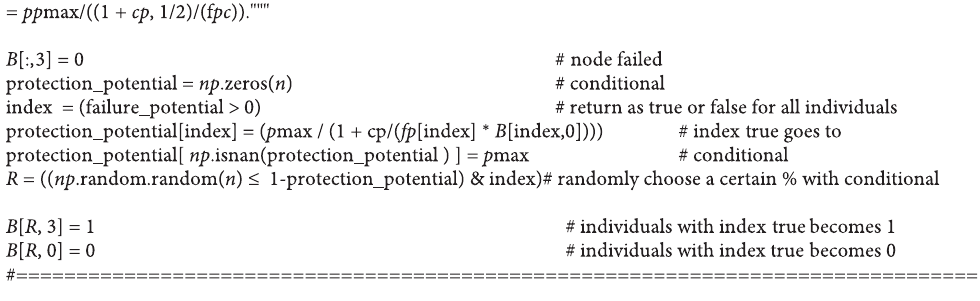
Figure 11: Code book: protection